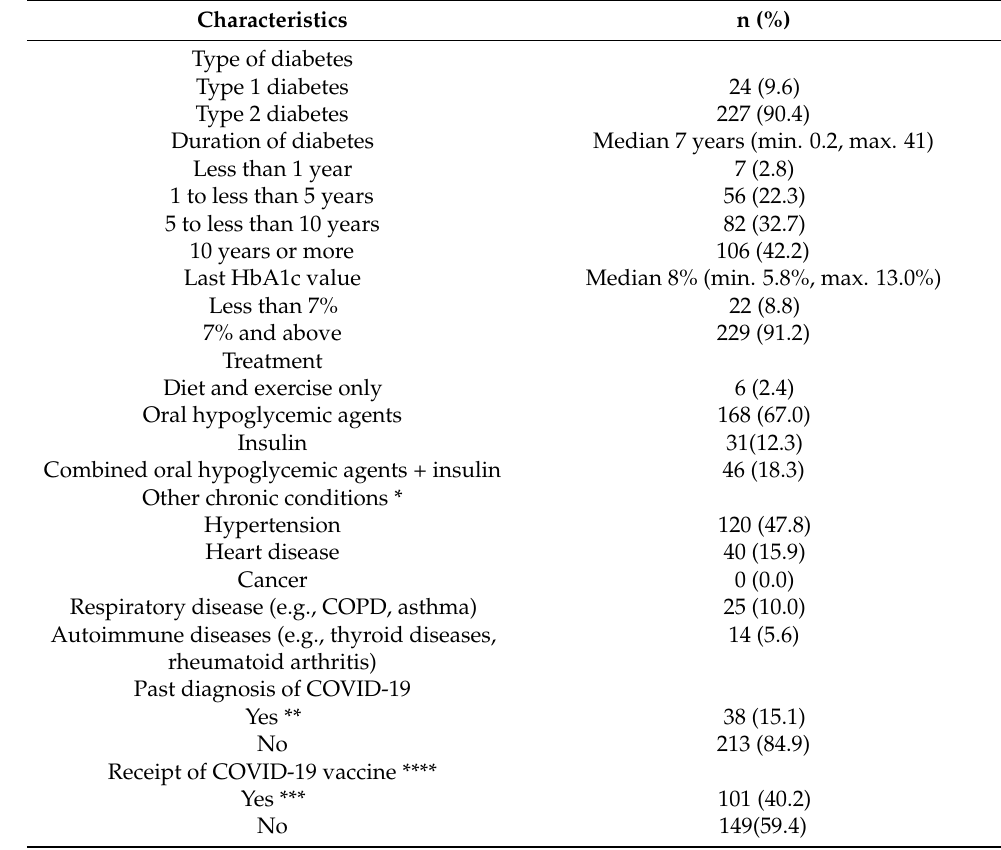
Table 3. Patients’ medical information (n =